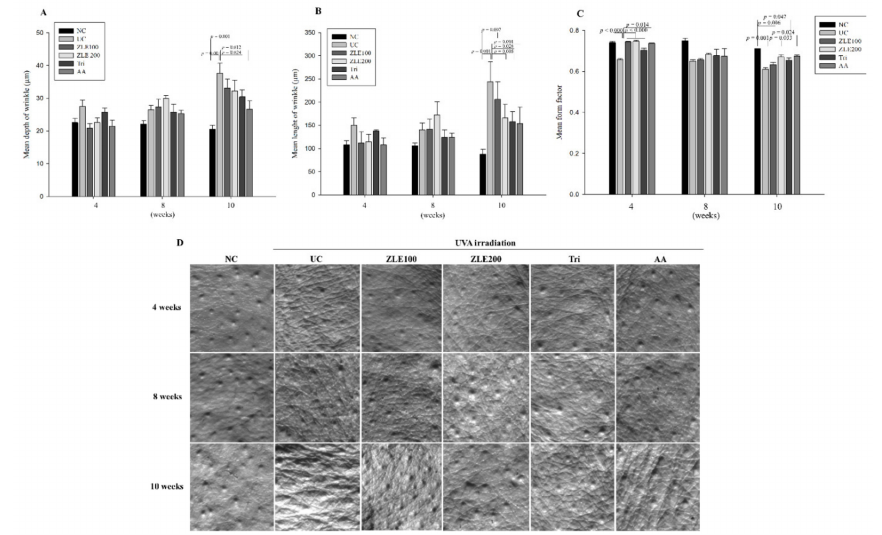
Figure 7. E ff ects of enzyme-treated Z. latifolia extract (ZLE) and tricin on the prevention of wrinkle formation in UVA-irradiated mice. The wrinkles on replica skin were measured by a Visioline VL650. ( A ) Mean depth of wrinkles. ( B ) Mean length of wrinkles. ( C ) Mean form factor. ( D ) Representative images of replica skin. Data are expressed as the mean ± SE. The p values are determined by ANOVA and Tukey’s HSD